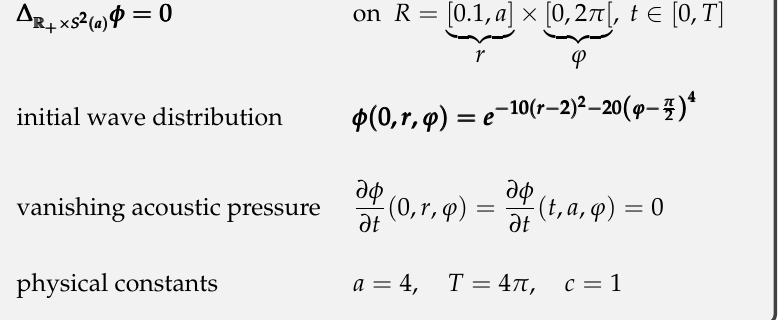
Figure 2. Boundary-value problem for a full simulation of acoustic wave propagation on the Einstein cylinder R + × S 2 ( a ) , using the characteristic length scale a = 4, speed c = 1, and running over the time interval t ∈ [ 0, T ] , with T = 4 π . The initial wave configuration represents an exponential “blob”. Two further conditions set the acoustic pressure, p = ρ 0 ∂φ / ∂ t , to zero. No further assumptions on symmetry are